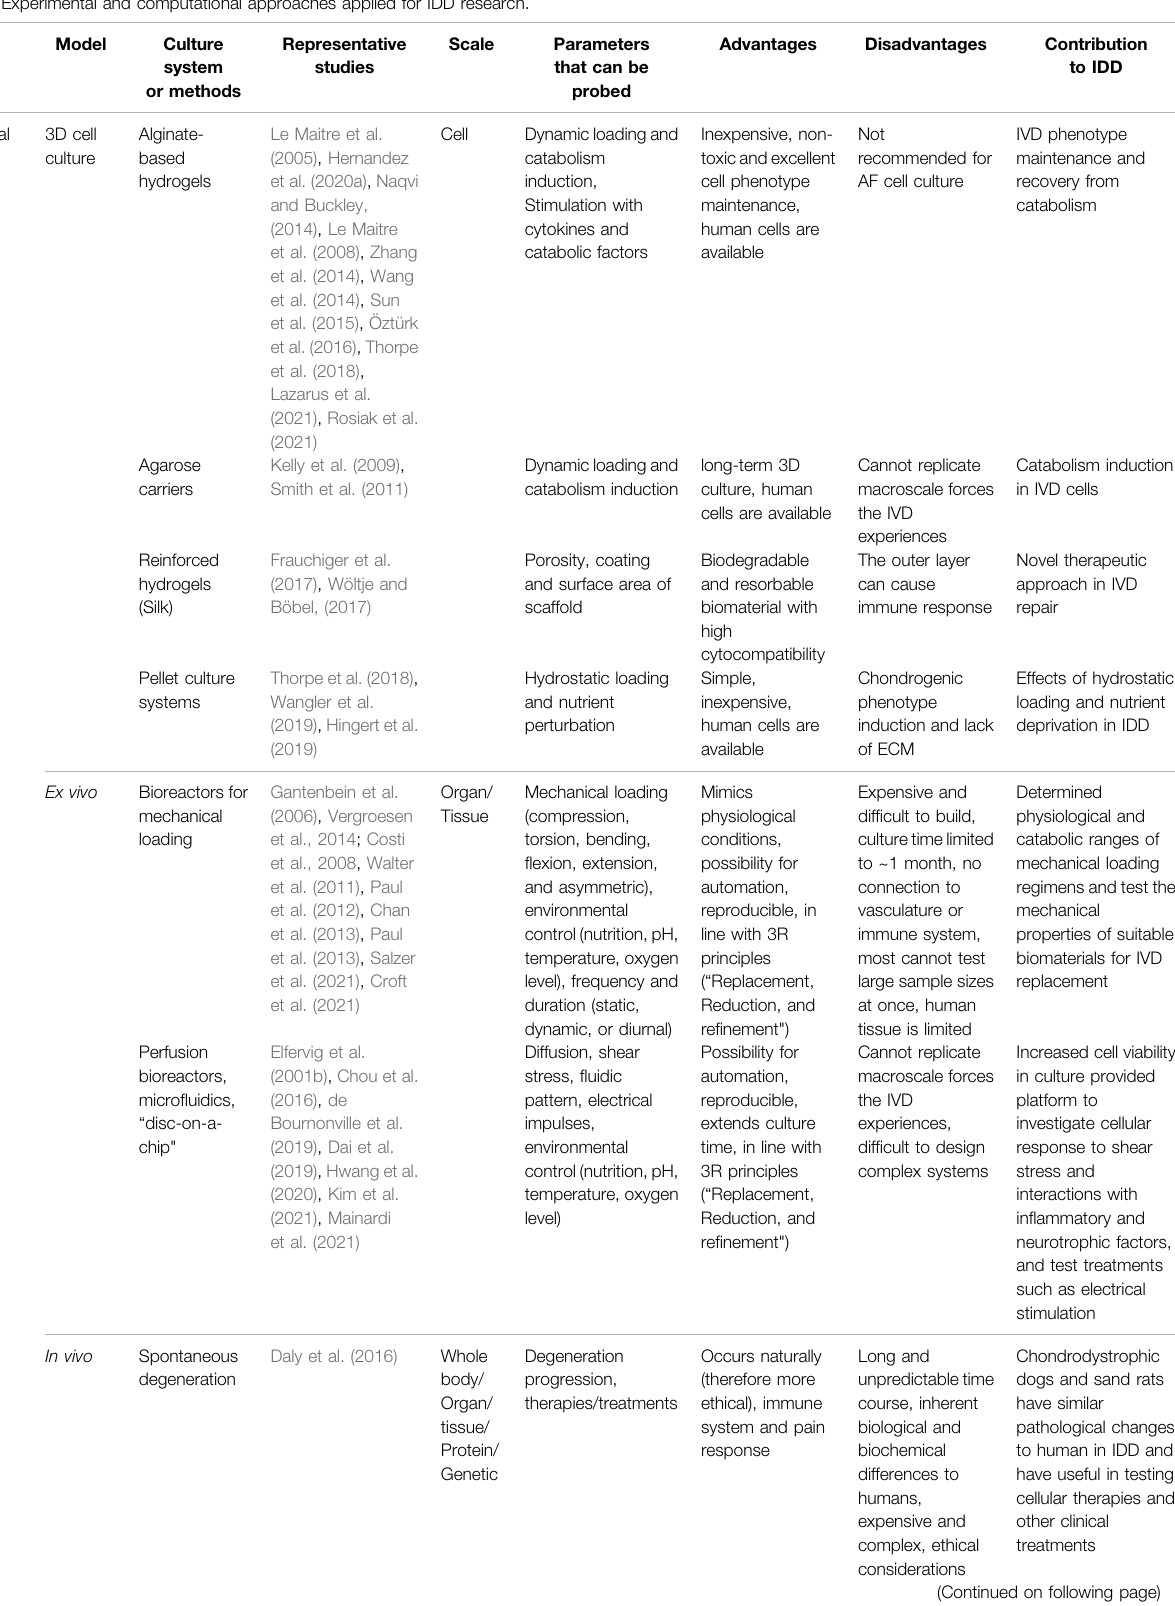
TABLE 2 | Experimental and computational approaches applied for IDD